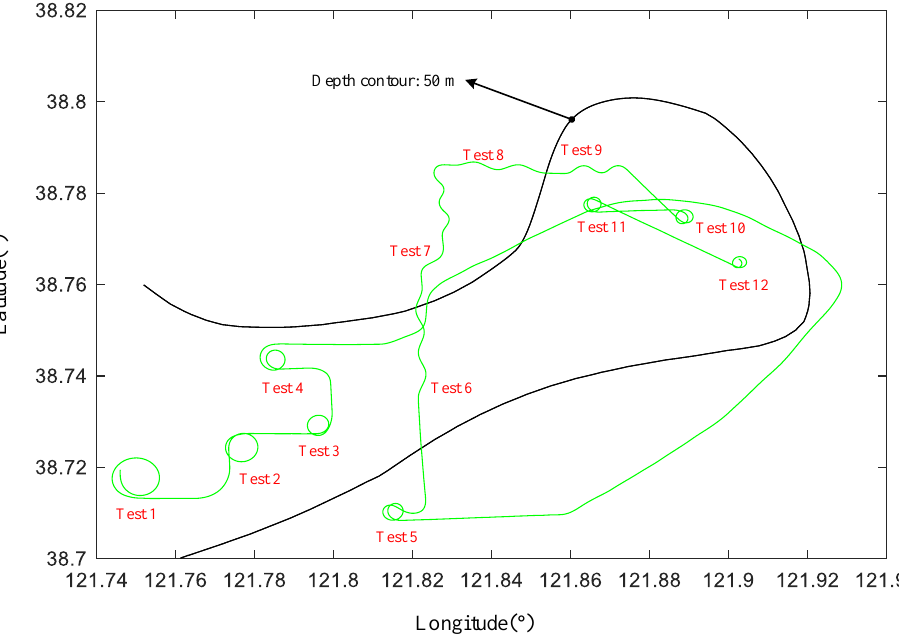
Figure 4. Sea trial area and water depth of Yukun test.